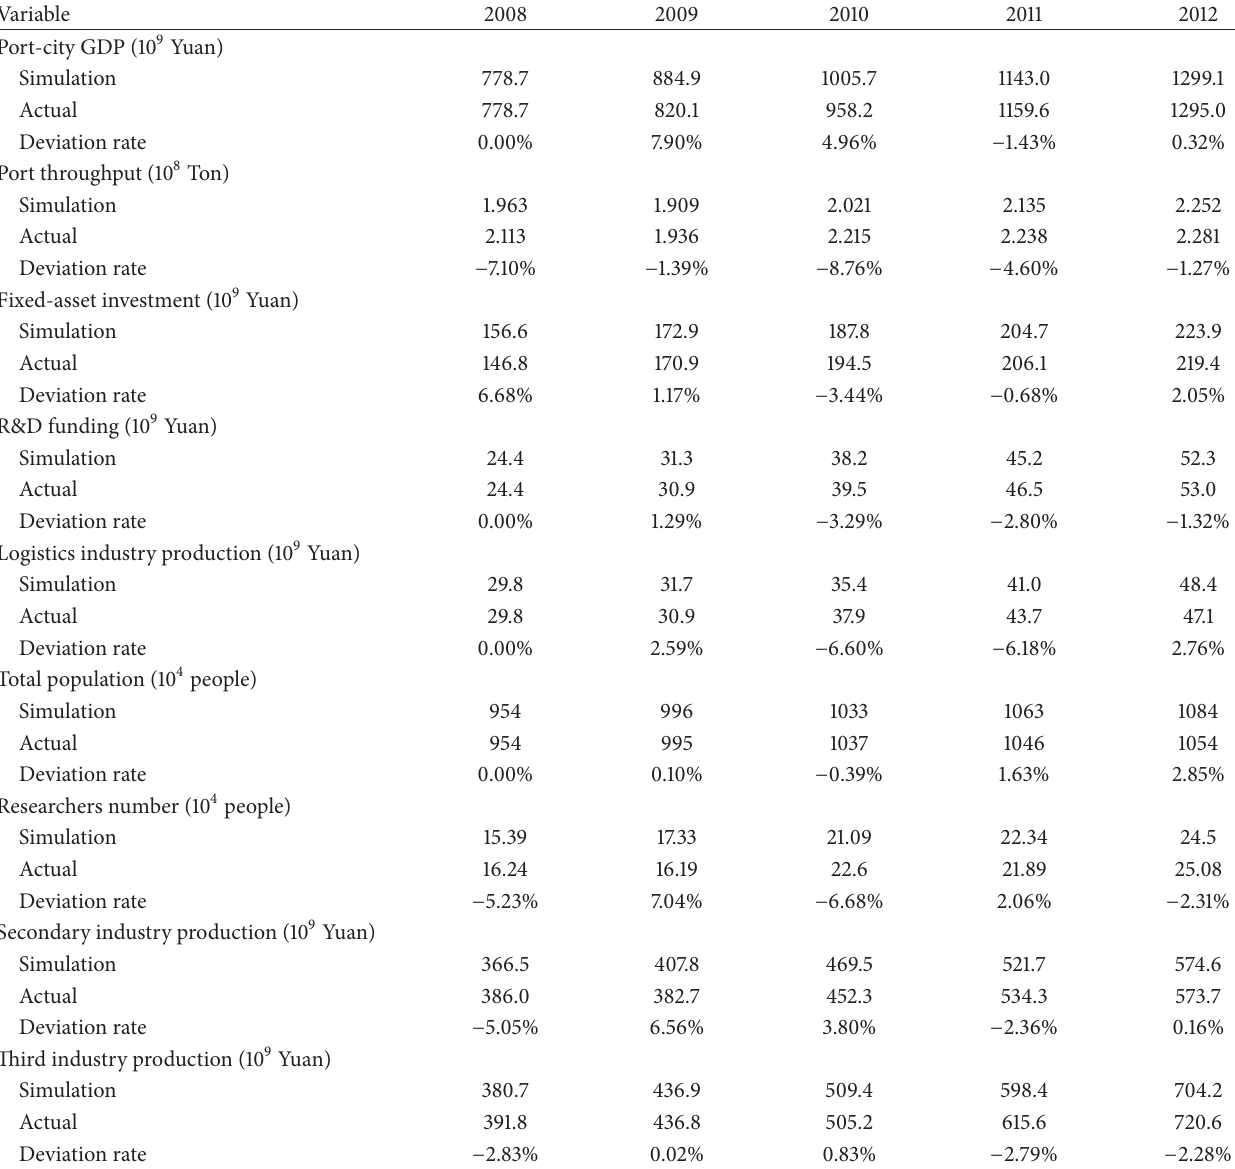
Table 1: The comparison between the simulation and actual value of the model’s main